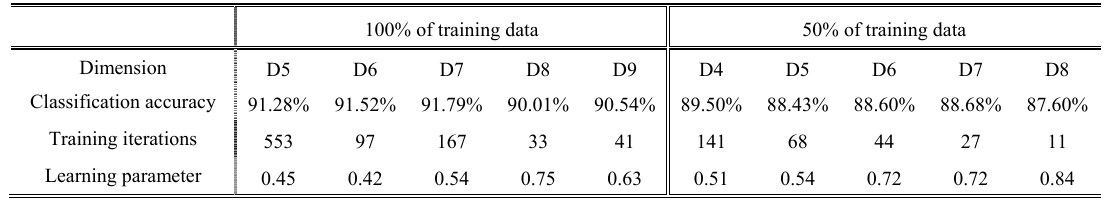
Table 6. Comparisons of the maximum classification accuracy and the corresponding training time with 100% and 50% of training